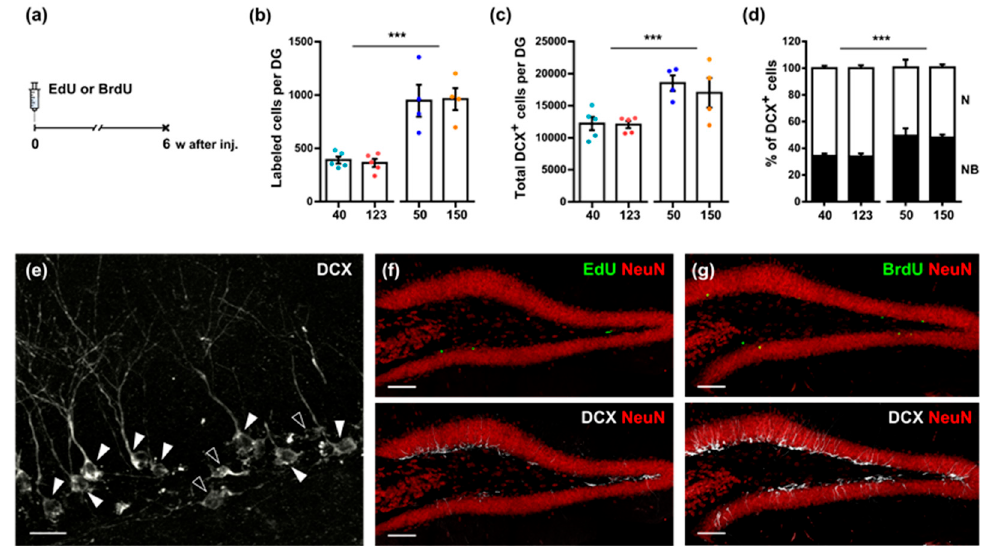
Figure 3. EdU and BrdU have different long-term effects on hippocampal neurogenesis. ( a ) Scheme of injections; mice were euthanized 6 weeks after a single EdU or BrdU injection. ( b ) Number of EdU + (40 and 123 mg/kg) and BrdU + (50 and 150 mg/kg) cells in the DG. ( c ) Total number of DCX + cells in DG. ( d ) The proportion of young neurons (N) and neuroblasts (NB) among DCX + cells. ( e ) Different subtypes of DCX + cells; empty arrowheads indicate neuroblasts (NB) and filled arrowheads indicate young neurons (N), the scale bar is 20 µm. ( f , g ) Representative images of EdU + , BrdU + , and DCX + cells, bar is 100 µm. ( b – d ) *** p < 0.0005, factor “Analog”, two-way ANOVA.